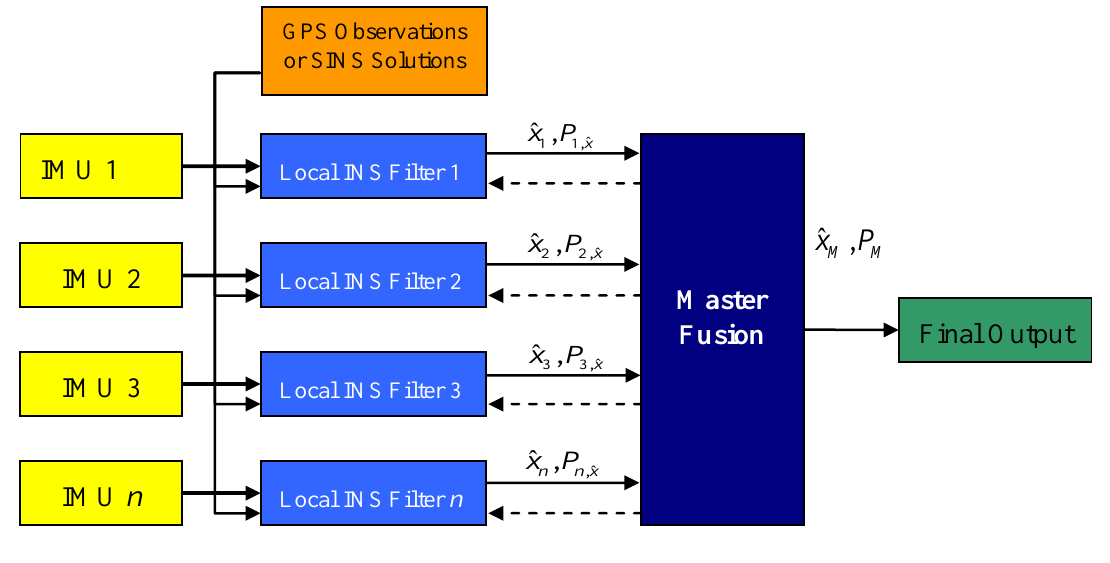
Figure 3. Federated Filter Architecture of Multiple